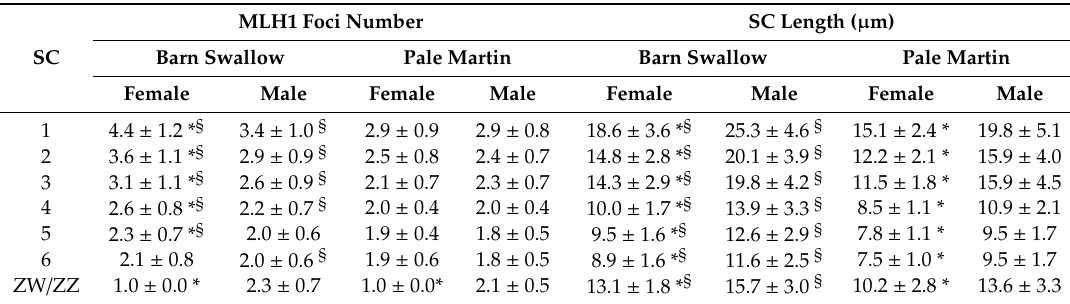
Table 2. Number of MLH1 foci and SC length (m ± S.D.) at the macroSCs in females and males of barn swallow and pale martin (number of SCs examined is shown in Table S1). MLH1 Foci Number SC Length ( µ m) SC Barn Swallow Pale Martin Barn Swallow Pale